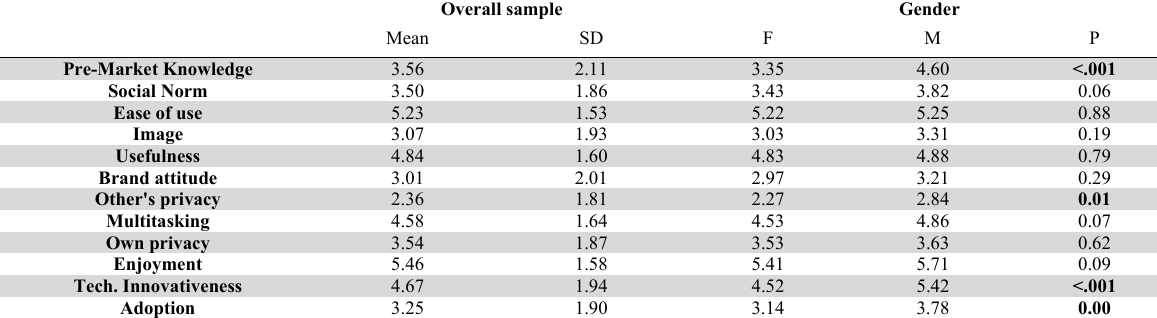
Factor analysis by gender